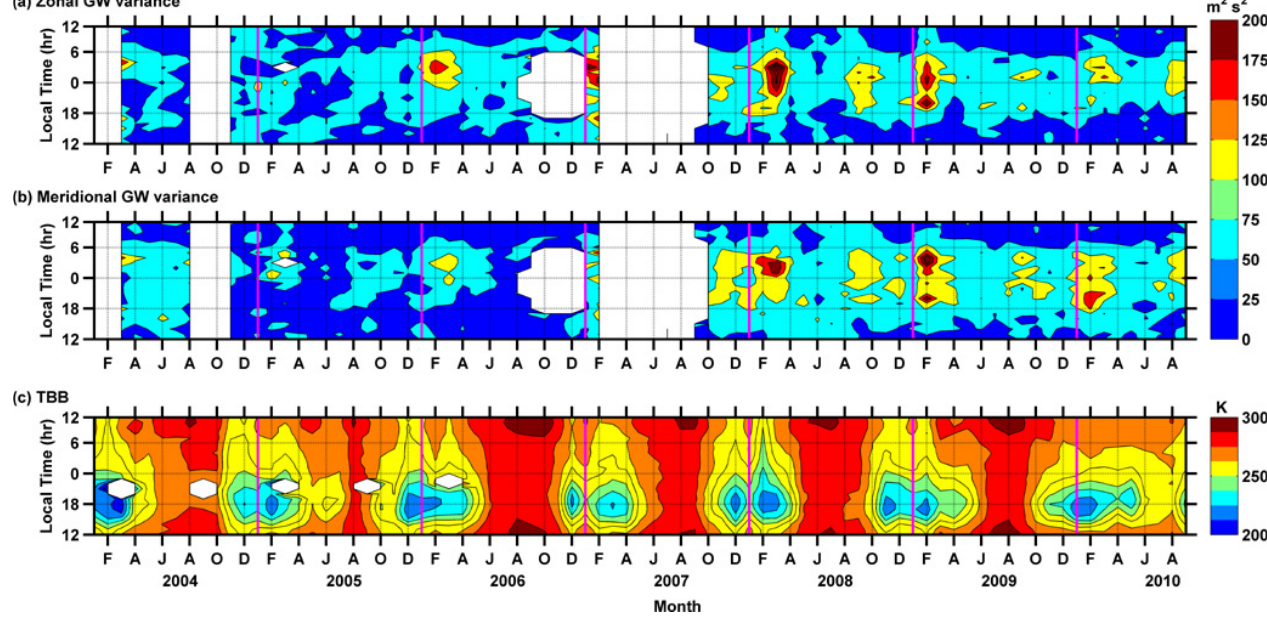
Fig. 3. Same as Fig. 2, but for all years from 2004–2010. Vertical lines are to separate the years.